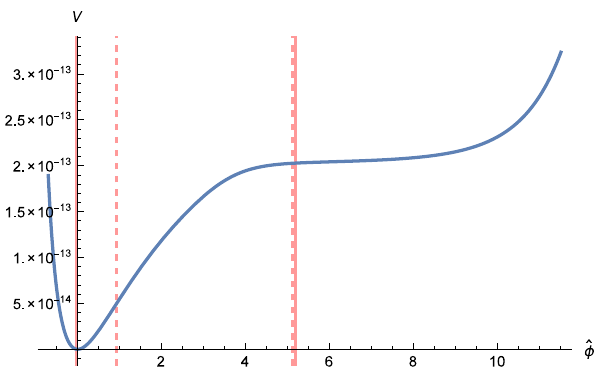
Figure 3 . Plot of the inflationary potential for the example set (4.22). The red vertical lines correspond to the walls of the K¨ahler cone while the dashed vertical lines denote horizon exit and the end of inflation where ǫ =